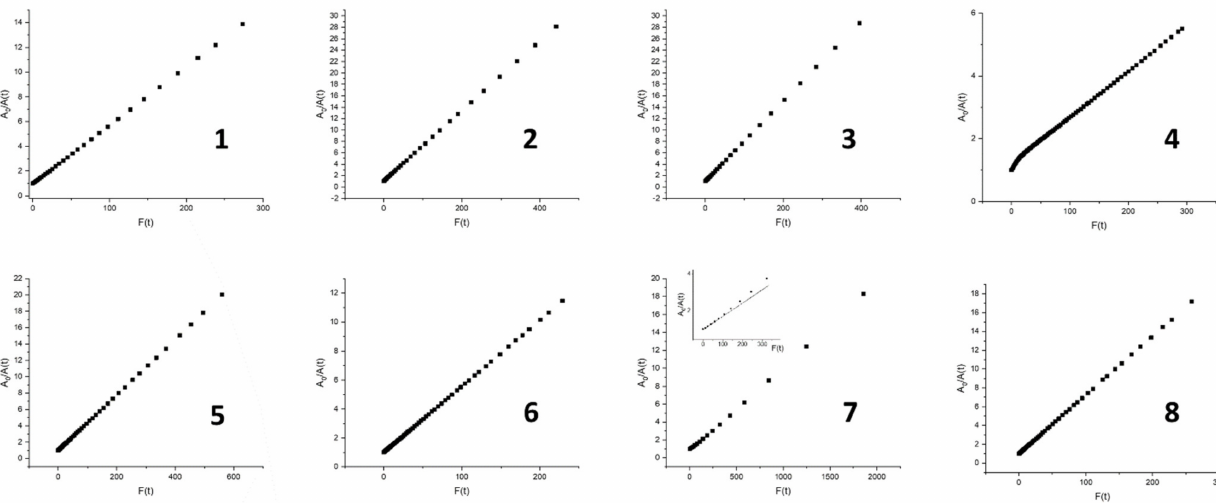
Figure 3. The ratio of the initial absorption, A 0 , to the absorption recorded after irradiating for time t , A ( t ), vs. F ( t ), obtained for the toluene solutions of porphyrins 1–8 at 293 K. The monitoring wavelengths correspond to the absorption maxima (see Table 1). The inset shows deviation from linearity in the initial period of irradiation of porphyrin